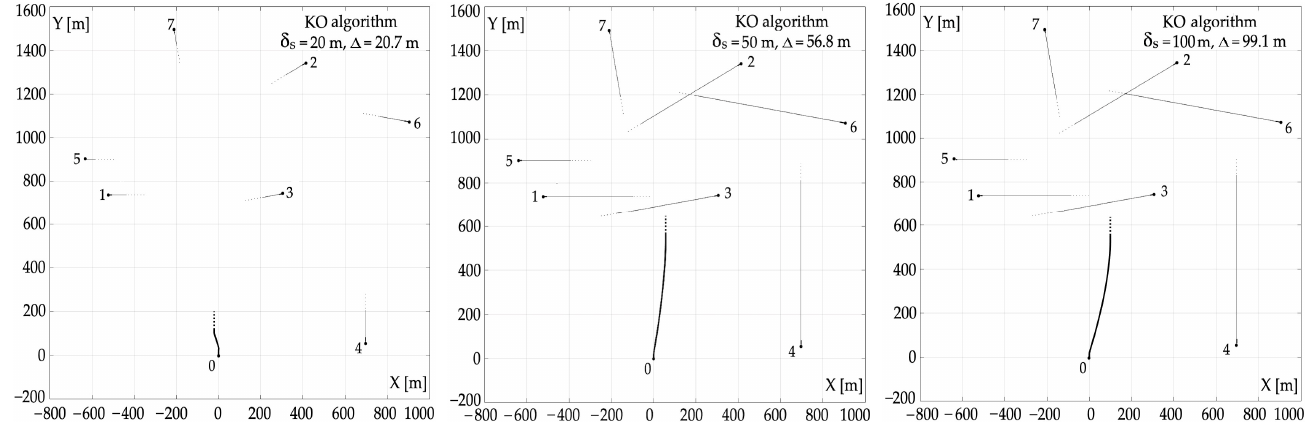
Figure 8. Safe kinematic trajectory of our autonomous vehicle in multidirectional traffic while passing seven other autonomous vehicles for three safe passing distance values.